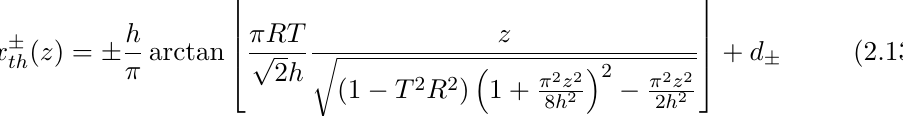
√ 2] , x ∈ [ x − ( z ) , x + ( z )] . BTZ BTZ